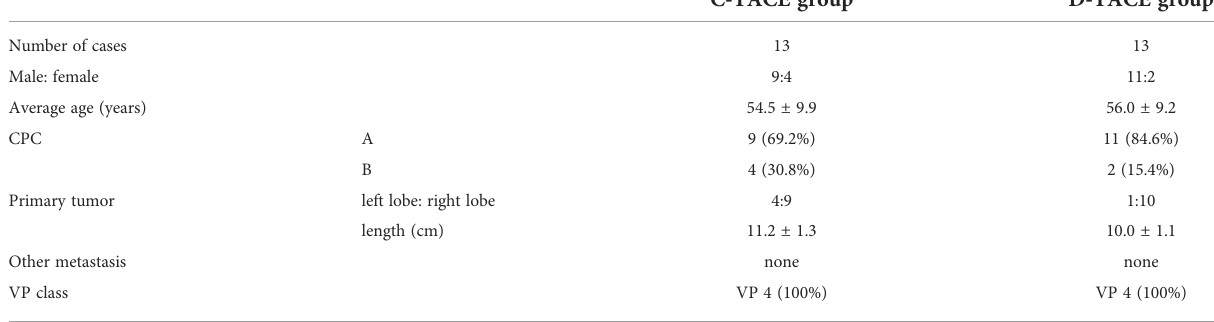
TABLE 1 General